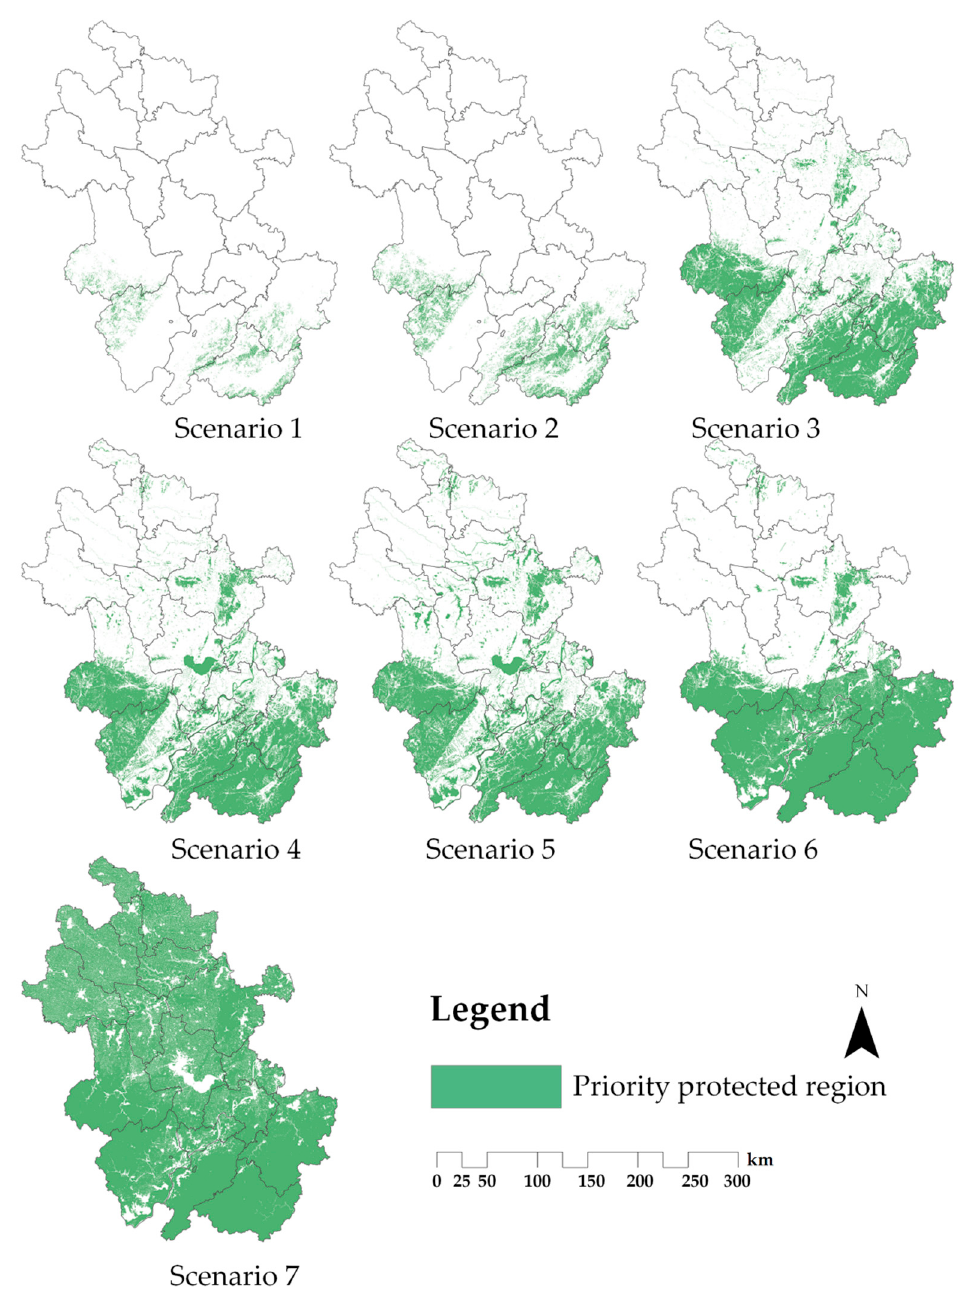
Figure 6. Priority protected areas in Anhui Province under each scenario.